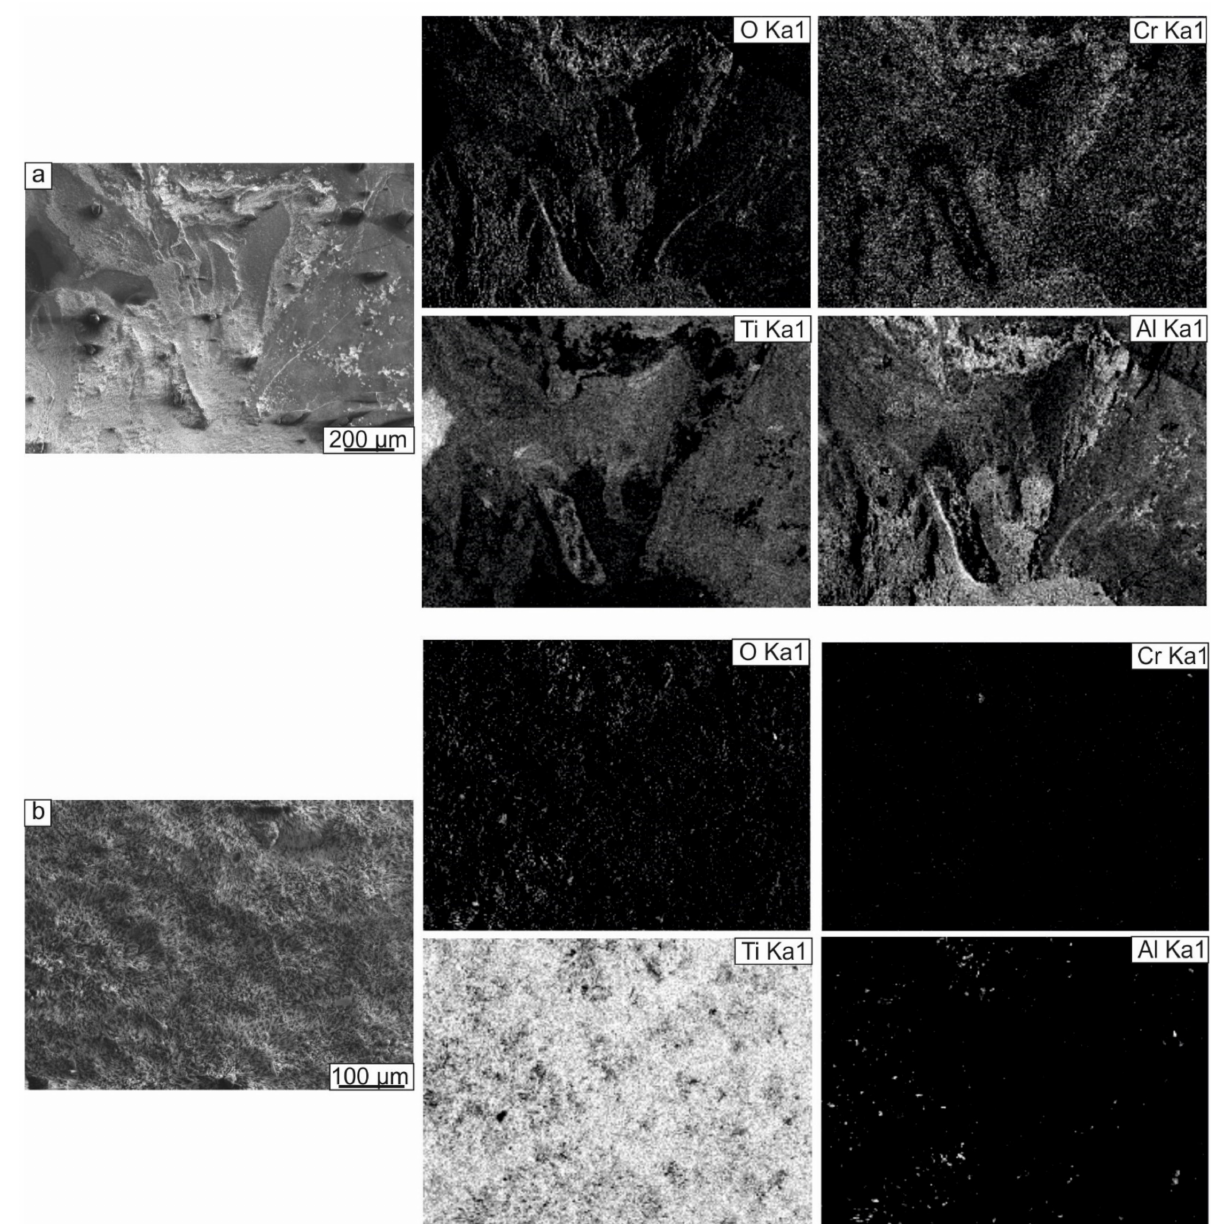
Figure 11. Oxide scale formed after oxidation at 800 ◦ C for 200 h on a surface of Ti-41Al-7Cr alloy: ( a ) Al 2 O 3 region, ( b ) TiO 2 region. Results of EDX